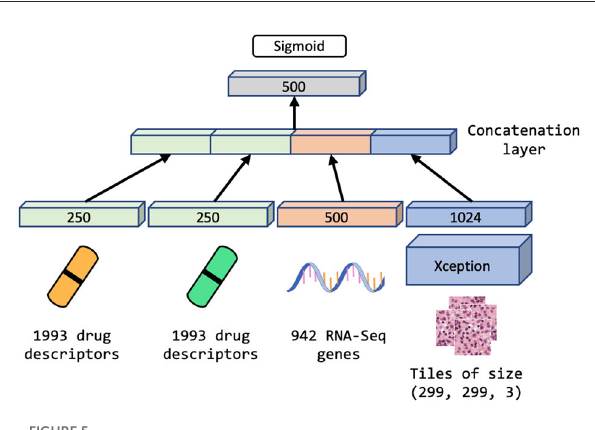
FIGURE5 Multimodal neural network (MM-Net) learns from drug descriptors, gene expressions, and tiles generated from whole-slide images, to predict drug response in